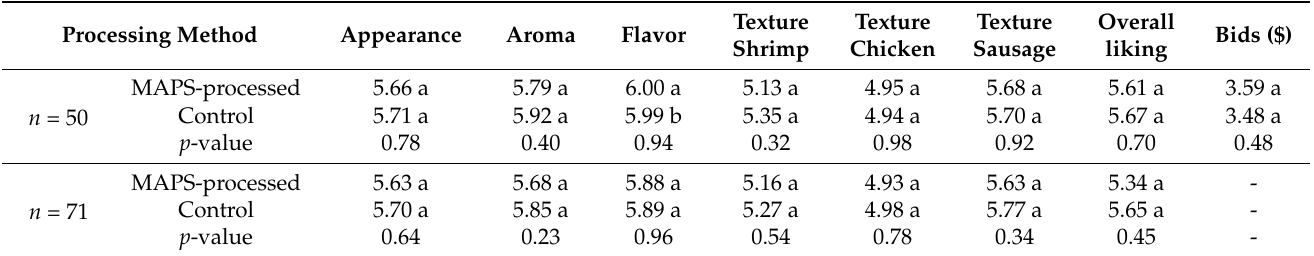
Different letters within a column (a, b) indicate that the tested parameter mean value was different among processing methods p < 0.05 as determined by using Tukey’s HSD. Mean values are collapsed over participants and storage time. Results range between 1 and 7 due to the use of a 7-point hedonic scale. Table 5. Consumer liking responses and bid values for jambalaya meals as evaluated by 50 and by 71 participants, over a 12-week storage period.